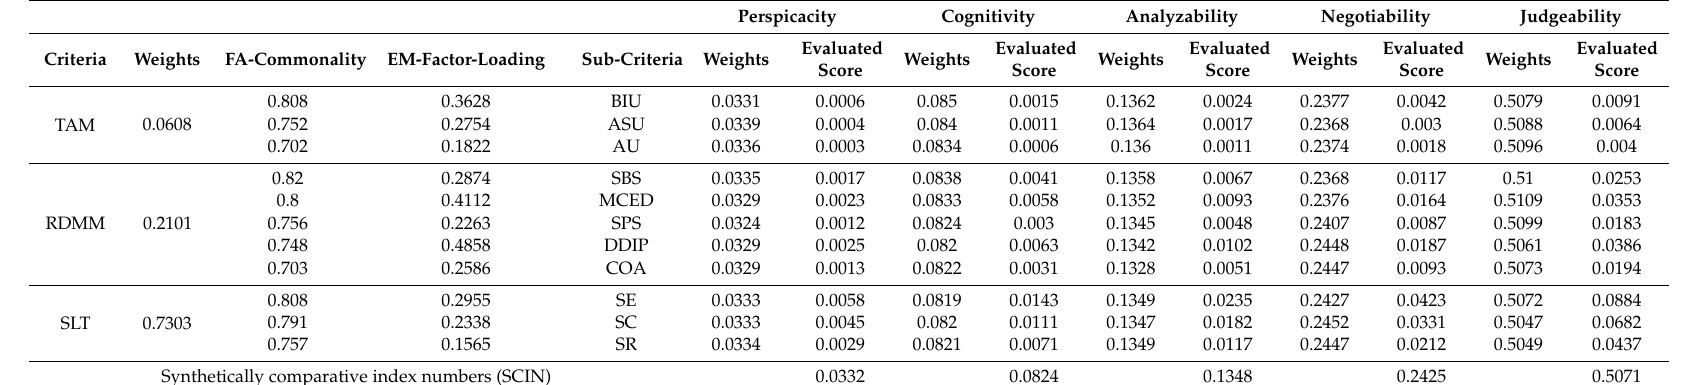
Table 7. The measured results of ANP